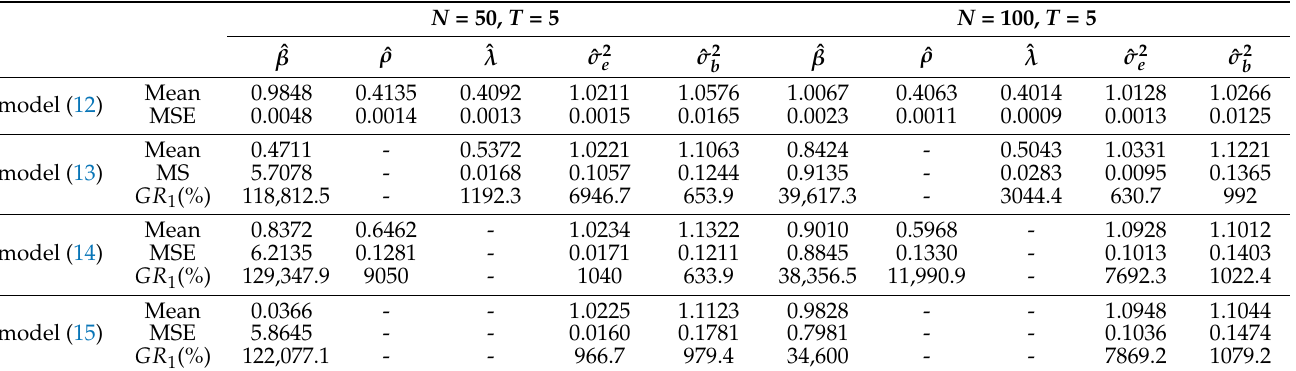
Table 5. Results of parametric estimates under the models